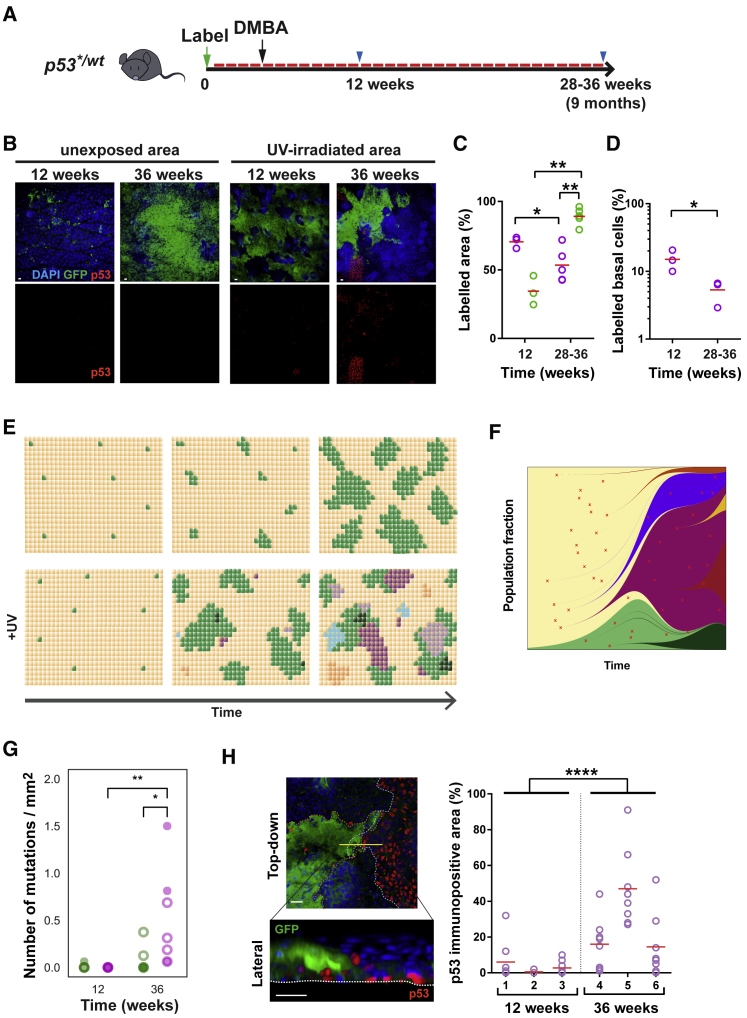
Long-Term UV Exposure Depletes Epidermis of p53∗/wt Cells(A) Protocol: AhcreERT-p53∗/wt mice were induced (green arrow), treated with a single dose of dimethylbenzanthracine (DMBA, black arrow), followed by repetitive sub-minimal erythema doses of UVB (red bars); blue arrows indicate sampling.(B) Confocal z stacks showing projected views of UV-irradiated and an adjacent unexposed area of IFE. Blue, DAPI; green, GFP, reporting p53∗ transcription; red, p53 indicating a p53 protein-stabilizing mutation. Scale bar, 20 μm.(C) Labeled projected area of p53∗/wt IFE in UV-exposed (purple circles; red line indicates mean value) and adjacent unexposed areas (green circles; red lines indicate mean value). n = 3 at the 12-week time point and n = 5 at the 28- to 36-week time point. Comparison between different time points, within same animal (unexposed versus UV irradiate area), ∗∗p = 0.0046, ∗p = 0.036 by unpaired two-tailed t test, ∗∗p = 0.0071 by paired t test.(D) Proportion of labeled basal cells in UV-irradiated IFE at indicated time points. Values are mean percentage from 5–8 fields per animal. n = 3 mice per time point. Red bars, mean value. ∗p = 0.042 by unpaired two-tailed t test.(E) Hypothesis: effect of prolonged low-dose UV on p53∗/wt clonal dynamics. Following induction, in the absence of UV, p53∗/wt clones (green) expand progressively in a background of wild-type cells (beige). In UV-exposed IFE, a wide variety of different mutant clones arises, indicated by multiple colors, some of which may expand, outcompete, and displace p53∗/wt cells from the IFE.(F) Simulation of clone competition under ongoing mutagenesis (see Video S1). A transgenic mutant (green) is induced at 1% frequency in a background of wild-type cells (yellow). Subsequently, new mutations (red cross, shades of green if in transgenic cells, other colors if in wild-type cells) are induced at random and assigned a fitness value as described in STAR Methods.(G) The number of mutations detected per square millimeter by the Shearwater algorithm in each 16-mm2 biopsy of mouse back skin: 3 induced and 2 non-induced mice at 12 weeks, 4 induced and 3 non-induced mice at 36 weeks. Solid circles, non-induced samples; open circles, induced samples. Green, non-exposed skin; purple, UV irradiated. ∗∗p < 0.01, ∗p = 0.02 by two-tailed Mann-Whitney test. Note that this method does not detect the induced and uninduced p53∗ allele.(H) Confocal z stacks showing p53∗/wt clone in direct contact with p53-immunopositive clone in UV-irradiated area (36 weeks post-induction). Blue, DAPI; green, GFP; red, p53. Scale bar, 20 μm. Dashed lines indicate outline of clones in top-down image and basement membrane in lateral view. Graph on the right shows proportion of p53 immunopositive area in UV-irradiated skin. Measurement of 8 fields of view per mouse are plotted individually. n = 3 mice per time point. Red lines indicate mean values. ∗∗∗∗p < 0.0001 by two-tailed Mann-Whitney test.See also Figure S7 and Tables S6 and S7.